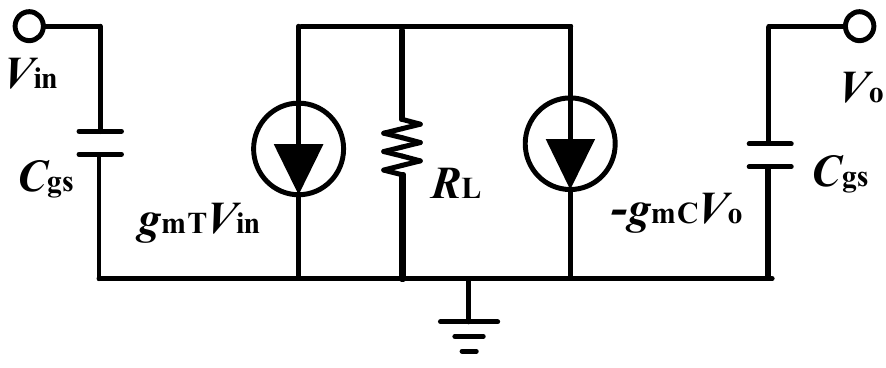
Figure 11. The small-signal model of the D-latch.